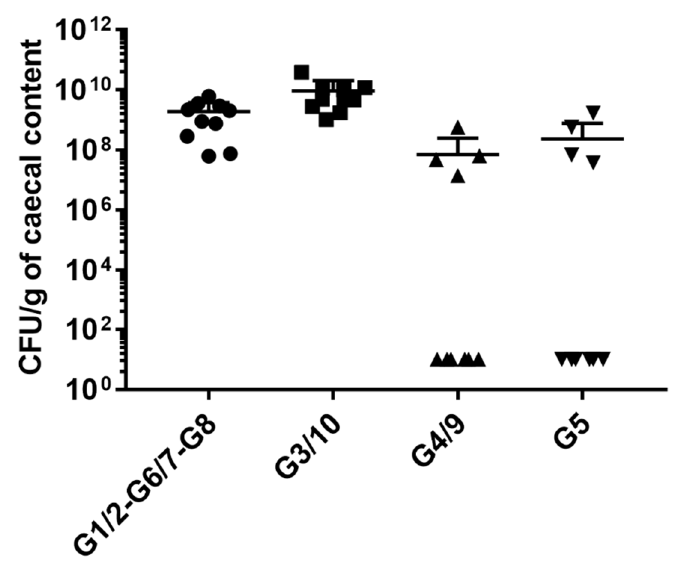
Figure 3. All Symbioflor2 ® genotypes colonize the intestine in Symbioflor2 ® -associated mice. The colonization level of each of the E. coli genotypes was quantified by cultivation and subsequent PCR on grown colonies obtained from the cecal content of gnotobiotic mice inoculated with Symbioflor2 ® . Cecal samples were plated on nutrient medium and cultivated aerobically. Colonies of G1-2, G6-7, and G8 showed a yellow colony color, and their identities were confirmed by PCR using the single primer pair used to detect the three genotypes (G1-2, G6-7, and G8 were not distinguishable by PCR due to the genomic similarities between the three genotypes). G3-10, G4-9, and G5 genotypes formed white colonies, and their identification as G3-10, G4-9, and G5 colonies was carried out by multiplex using the three specific primer pairs. Absolute abundances of white and yellow genotypes were calculated per gram of cecal sample.